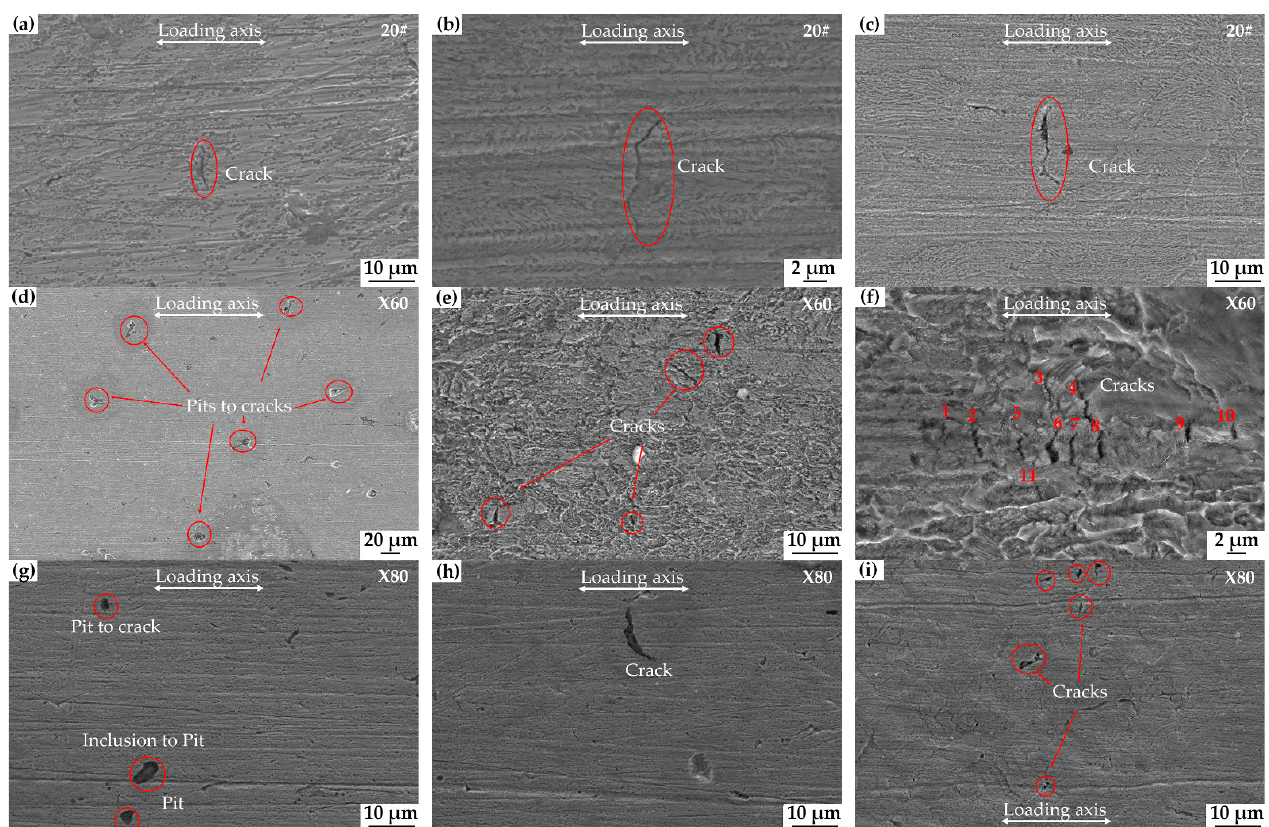
Figure 8. Surface morphology of 20# ( a – c ), X60 ( d – f ), and X80 ( g – i ) after SSRT to UTS level and immersion for different times in near-neutral pH environment: 24 h: ( a , d , g ), 48 h: ( b , e , h ), 72 h: ( c , f , i ).